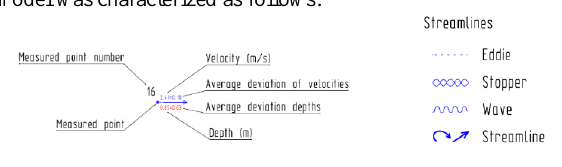
Figure 9. Schematization of measurements with respect to recorded points